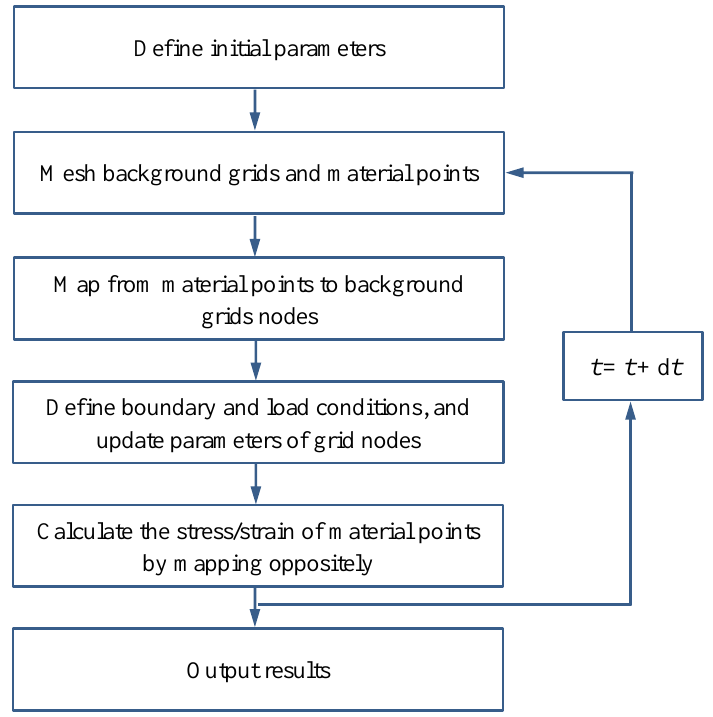
Figure 6. Flow chart of the analysis of MPM.